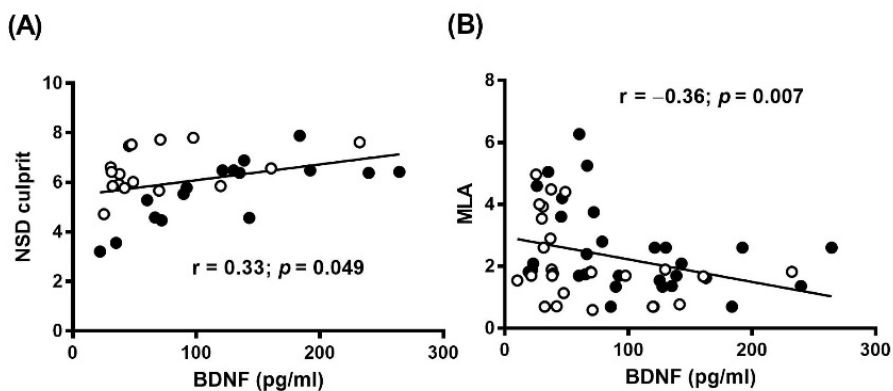
Figure 3. Relation between circulating BDNF levels and OCT features. Correlation between plasma BDNF and ( A ) MØI in terms of normalized standard deviation (NSD) culprit, or ( B ) Minimal Lumen Area (MLA) in CAD patients. SA: black dots, and AMI: white dots.